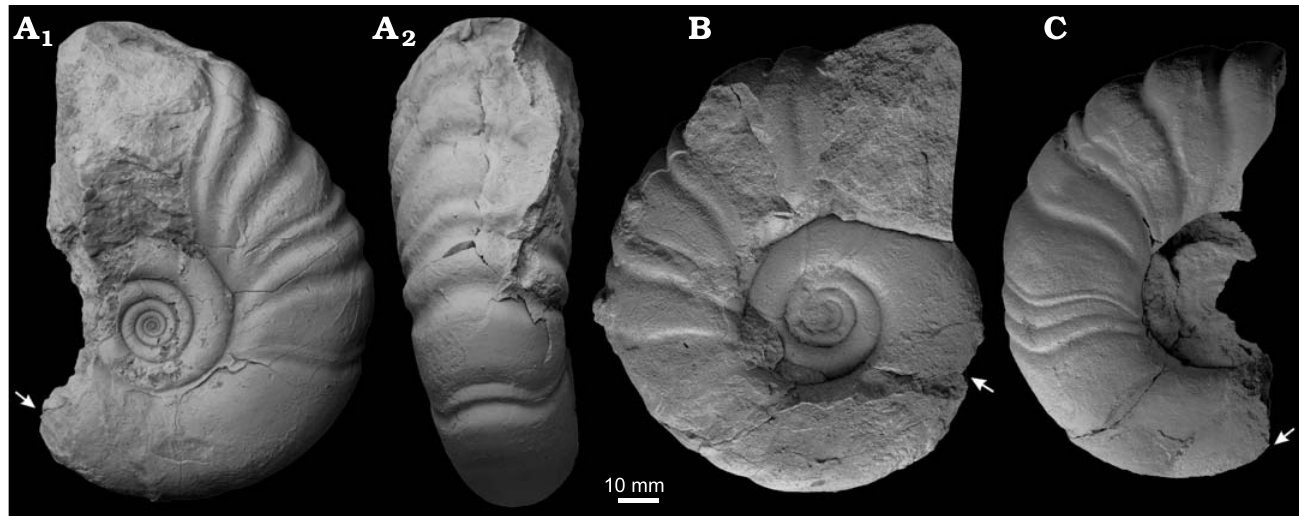
10 Fig. 7. Macroconchs of the gaudryceratid ammonoid Anagaudryceras calabozoi Raffi and Olivero sp. nov., from early Campanian (Cretaceous), Antarctica, Rabot Formation, Redonda Point locality (A) and Hamilton Norte locality (B, C). A . CADIC PI 411, holotype, phragmocone and part of the body chamber in lateral (A 1 ) and ventral (A 2 ) views. B . CADIC PI 456, phragmocone and part of the body chamber in lateral view. C . CADIC PI 464, phragmocone and part of the body chamber in lateral view. Arrows mark the beginning of the body chamber.